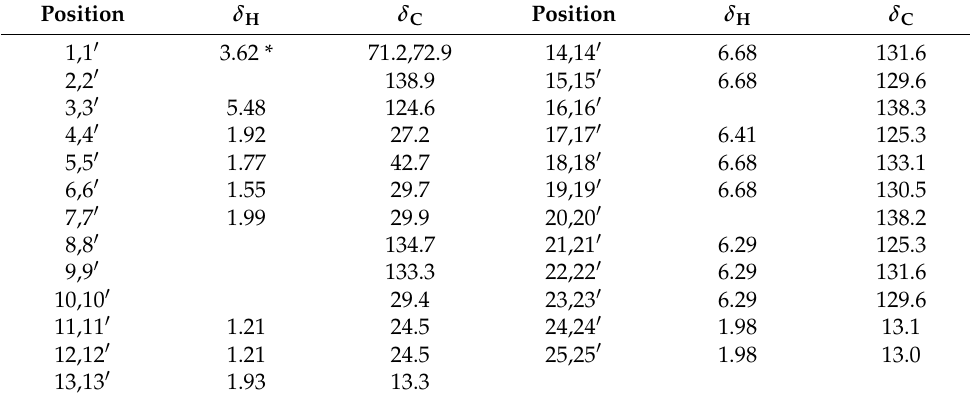
Table 1. NMR spectroscopic data for the arthroxanthin.